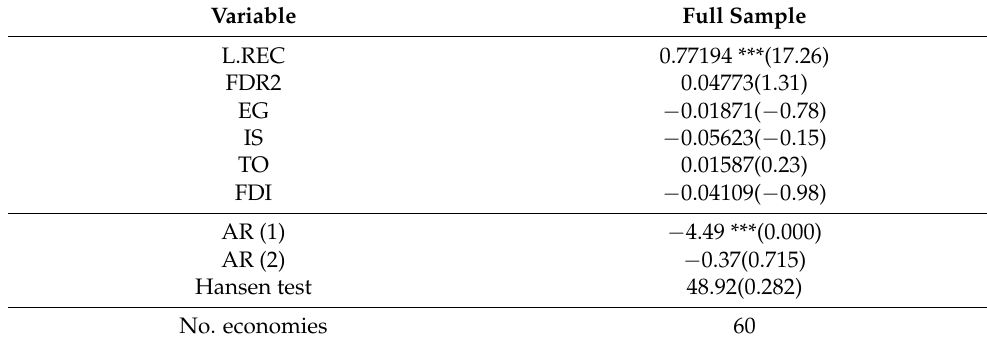
Table 12. Regression results with